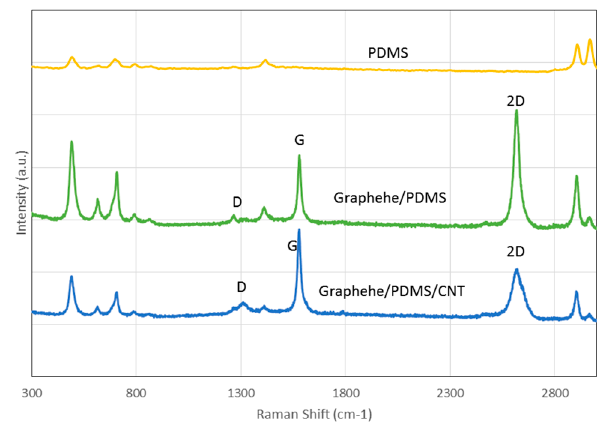
Figure 2. Raman spectra of PDMS, 3D Graphene/PDMS and 3D